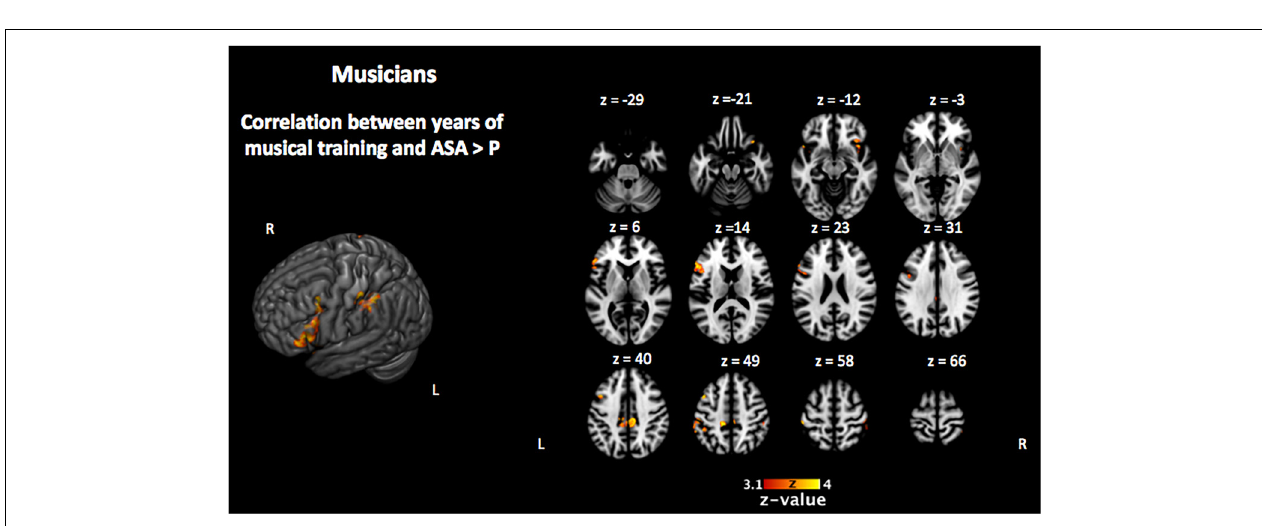
FIGURE 5 | Two-sample comparison of Mus > Cont for the correlation between the activation in the encoding phase [VSA > P] contrast with the correct responses of each subject in the auditory memory tasks of the VSA condition trials (corrected p < 0.05). Mus, musically trained children; Cont, control children; VSA, visual selective attention; P, passive; CR, correct responses; AMT, auditory memory task.